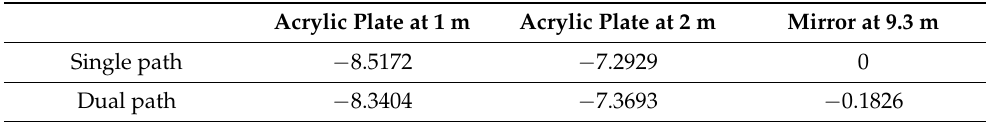
Figure 15. Depth histograms for the single-path and dual-path situations. The distance between the acrylic plate and the objective mirror was 8.3 m. Table 4. Measured relative mean depths based on the single-path situation (m).